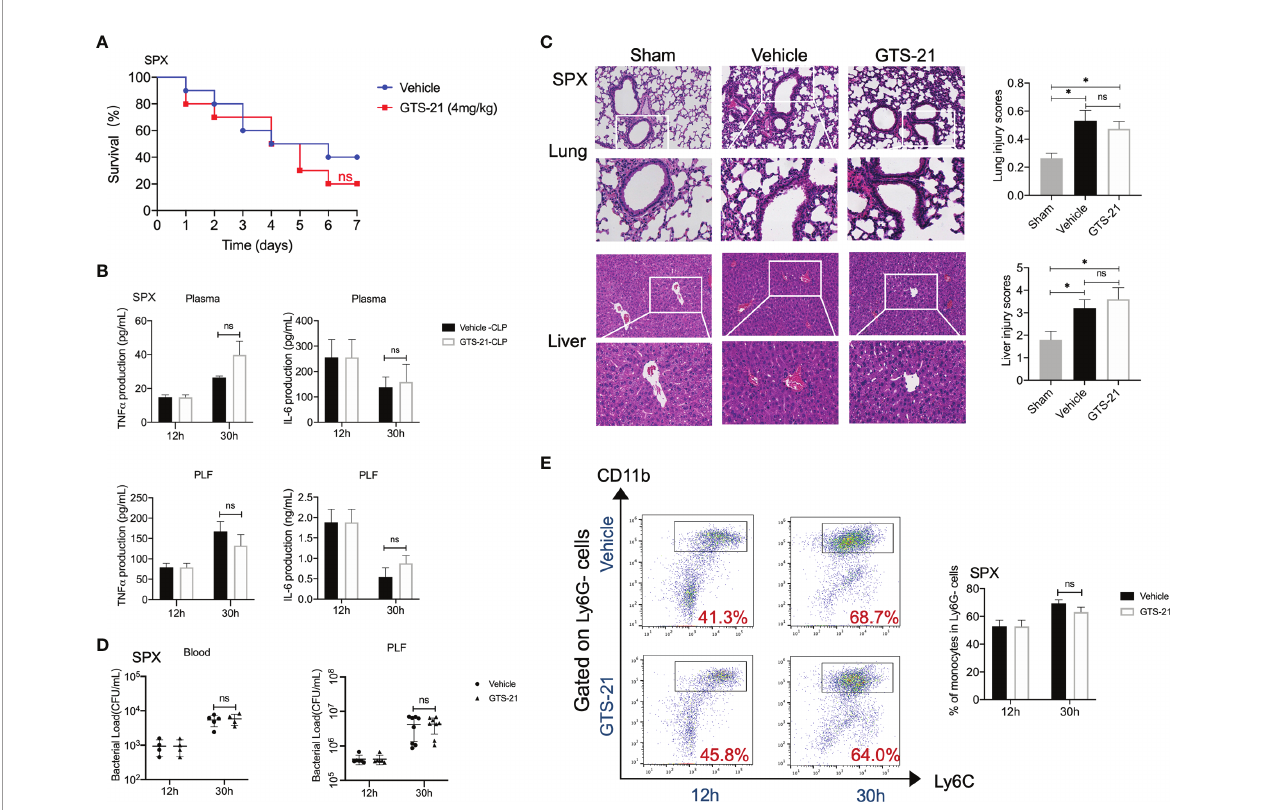
FIGURE 4 | The spleen is required for the protective response of GTS-21 in the treatment of septic mice. Splenectomies were performed and 1 week later, splenectomized mice were subjected to CLP procedure. Then, GTS-21 or vehicle treatment began 12h after CLP and was administrated twice a day for 3 days. (A) To determine survival, mice were monitored for 7 consecutive days ( n =10 mice/group). (B) At indicated time intervals, PLF and blood samples were collected ( n =6~8 mice/group), PLF and plasma TNF a and IL-6 levels were measured using ELISA kits. (C) Pulmonary and liver samples were obtained (n=5 mice/group) and stained for H&E histopathology (original magni fi cation, × 100 and ×200). The slides were histopathologically evaluated as described in Materials and Methods. (D) At indicated time point, peritoneal and serum bacterial loads in GTS-21 or vehicle-treated mice were quanti fi ed (n=6~8 mice/group). The horizontal bar represents the mean for each group. Symbols represent individual mice. (E) Splenectomized mice treated with GTS-21 or vehicle were sacri fi ced 30h after CLP, peritoneal cells were collected (n=6~8 mice/group) and stained for monocytes markers (CD11b+Ly6G-Ly6C+). Percentages of monocytes were measured by fl ow cytometry. Results are expressed as mean ± SEM. No statistical difference (ns, P>0.05) and *p < 0.05 for GTS-21 vs